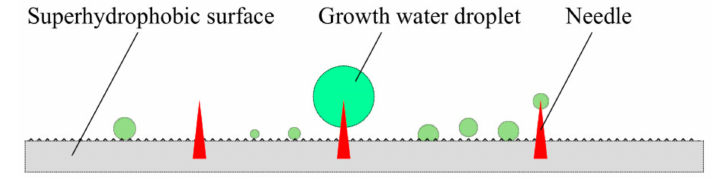
Figure 7. Condensation on a hybrid surface